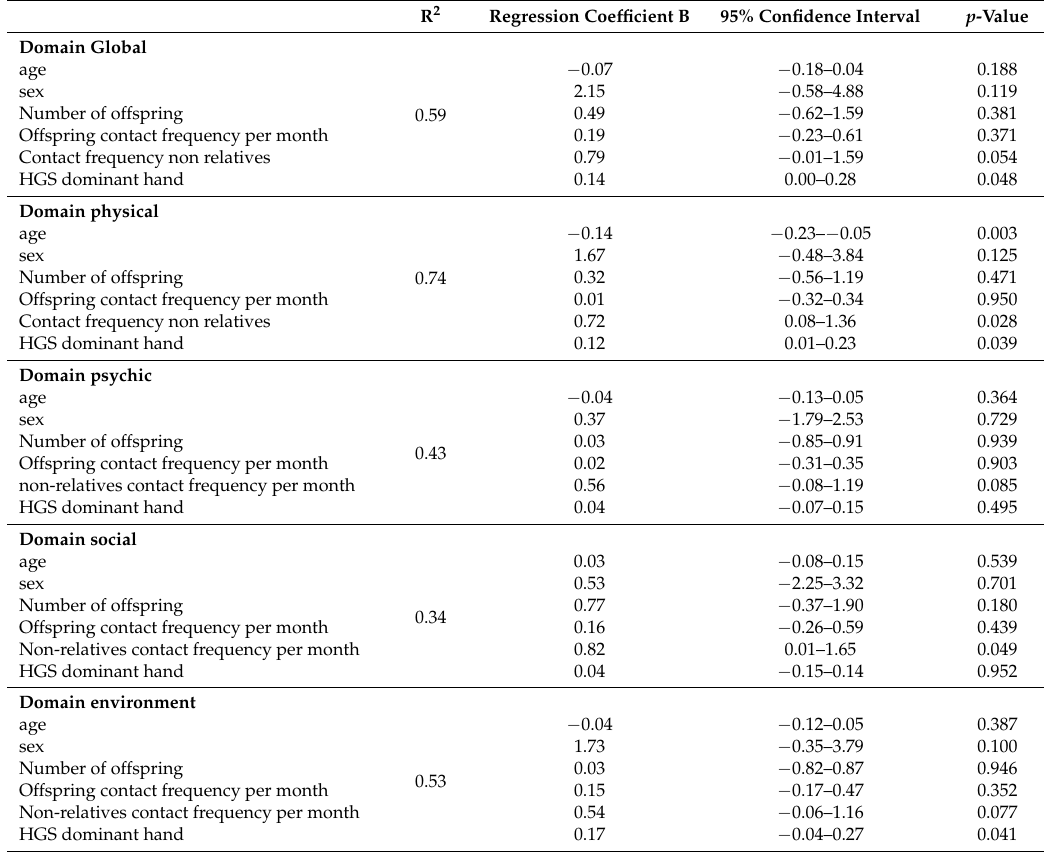
Table 5. Multiple regression analysis for each domain separately: Impact of sex, age, number of offspring, contact frequency and handgrip strength on health related quality of life. R 2 Regression Coefficient B 95% Confidence Interval p